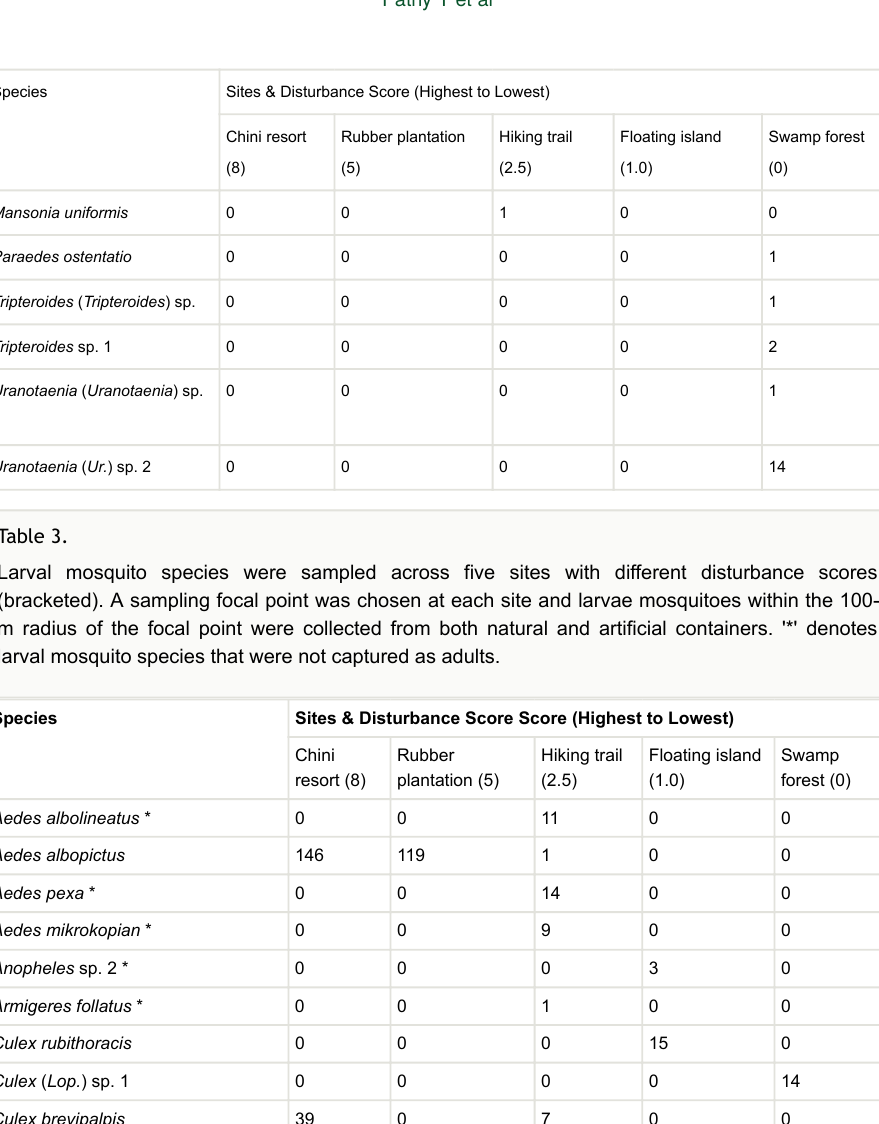
Toxorhynchites splendens *